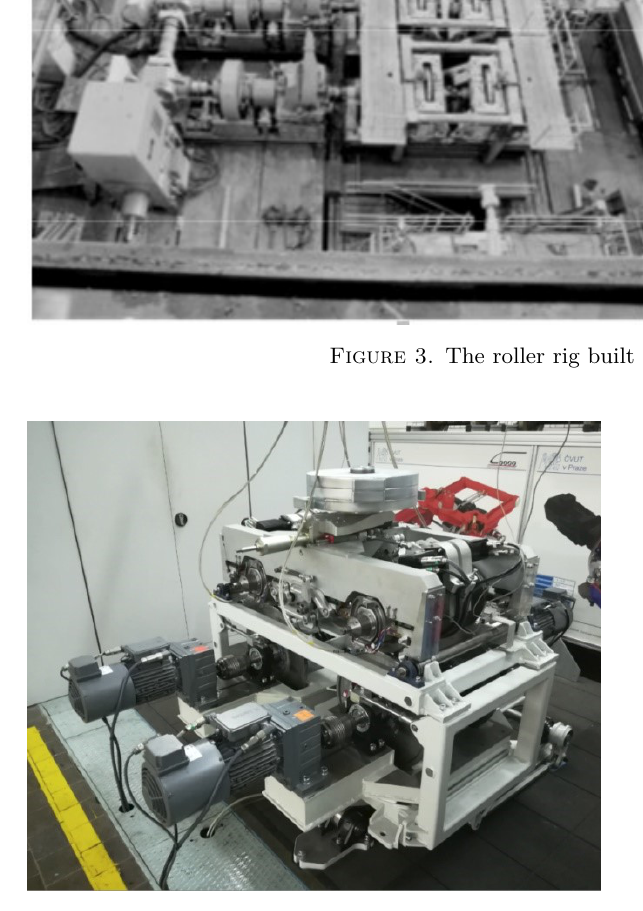
Figure 4. The roller rig – Faculty of Mechanical Engineering at CTU in Prague.